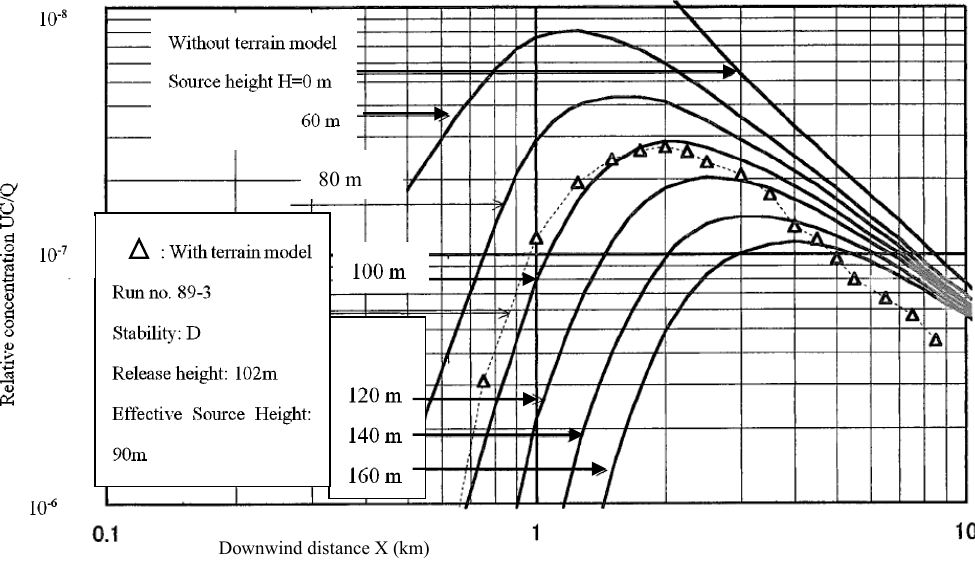
Figure 3. An example determination of effective source height (He’) [4].